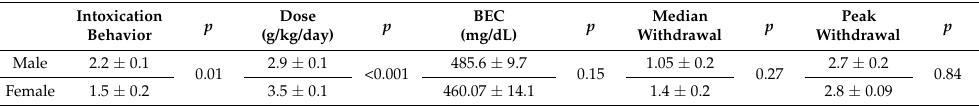
Table 4. Binge data for males and females.